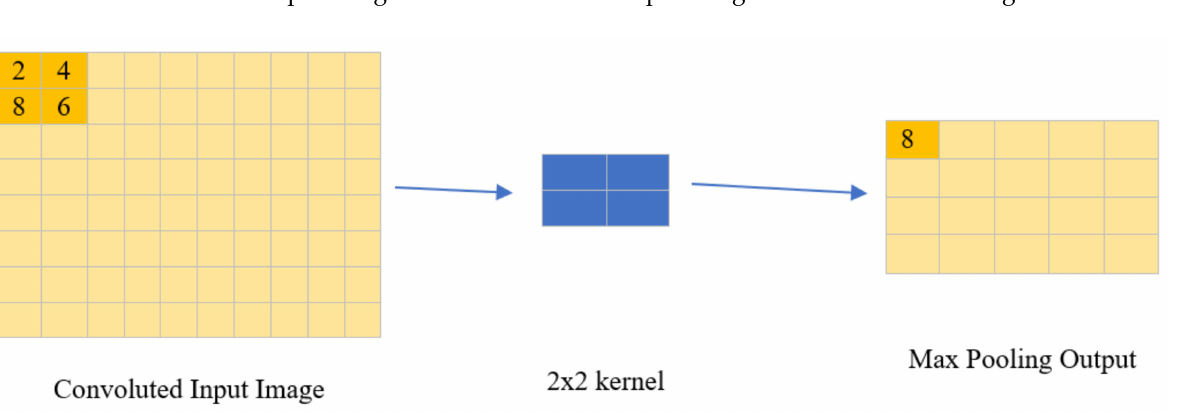
Figure 5. Illustration of function performed by kernel in max pooling layer for each 2 × 2 grid in a convolved